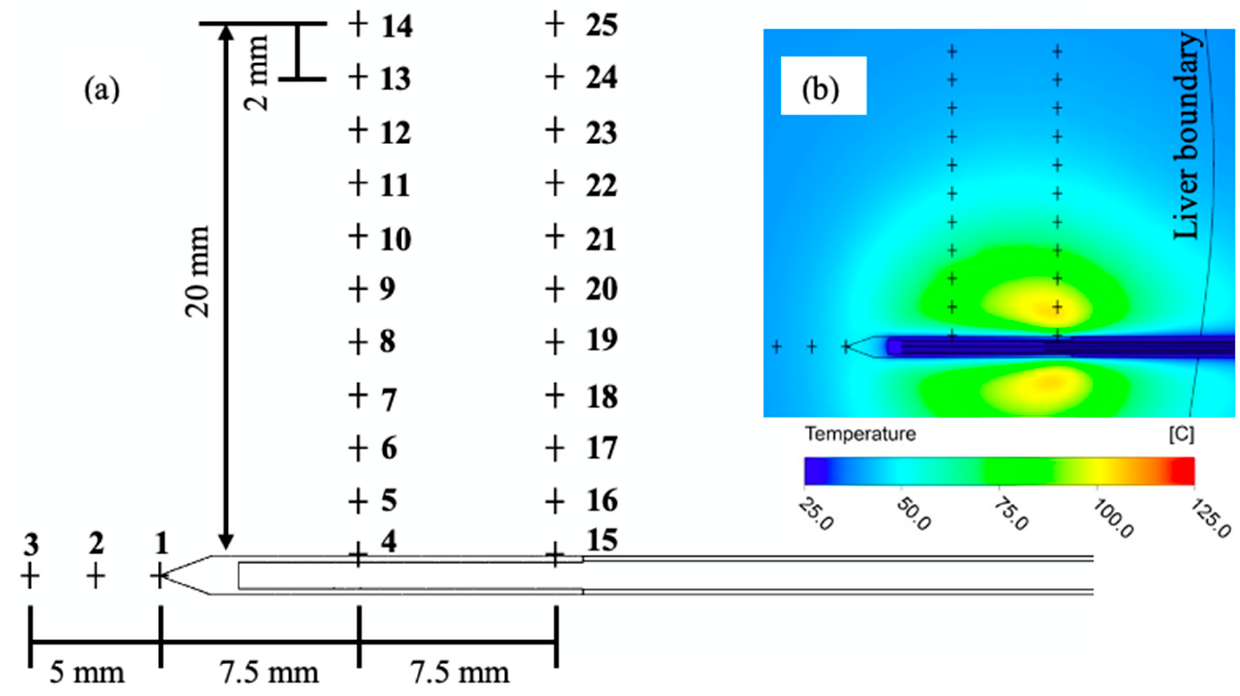
Figure 7. Locations of the measurement points. ( a ) Physical locations of the measurement points, numbered sequentially, relative to the probe tip, and ( b ) illustration of the locations within a temperature color contour diagram (time = 120 s at 30 W with a coolant flow rate of 1 g/s).